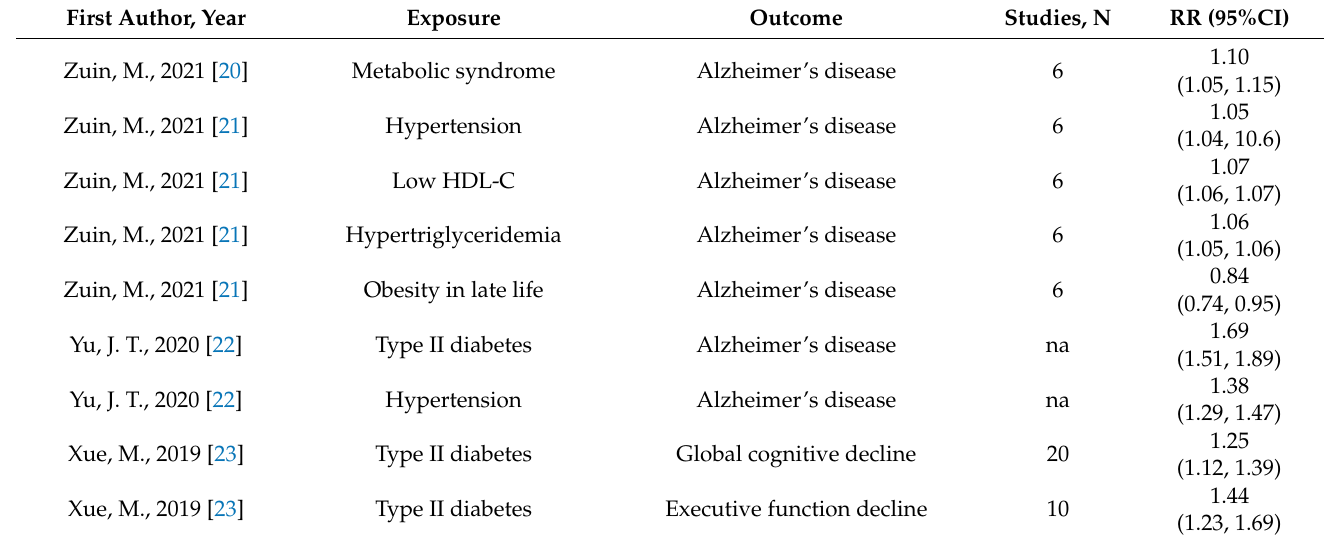
Table 1. Meta-analyses of epidemiological studies evaluating the association of metabolic syndrome and its components with cognitive